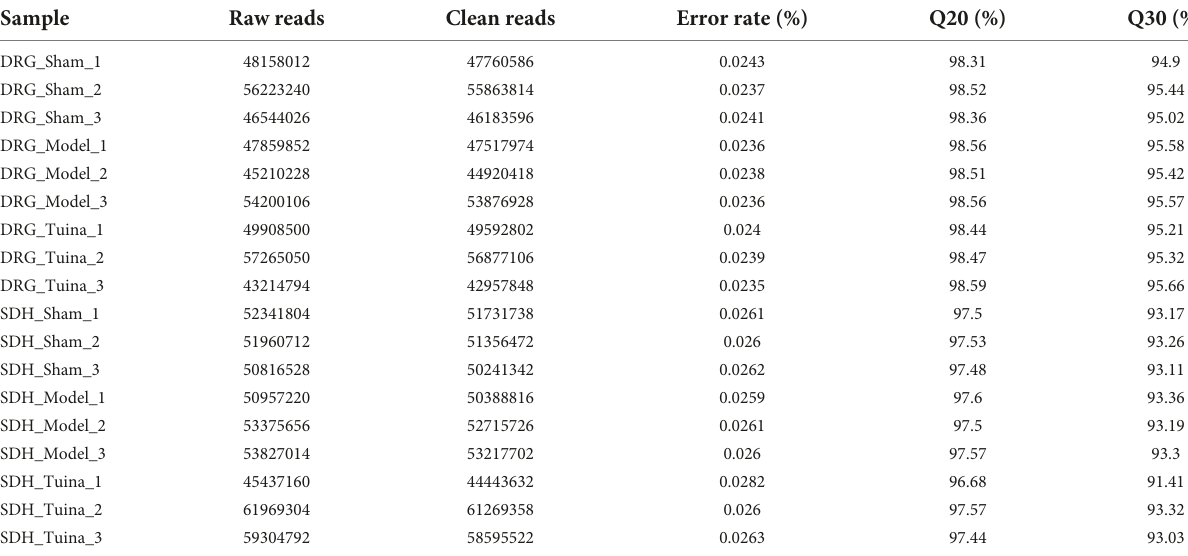
TABLE 2 Sample sequencing information and quality control